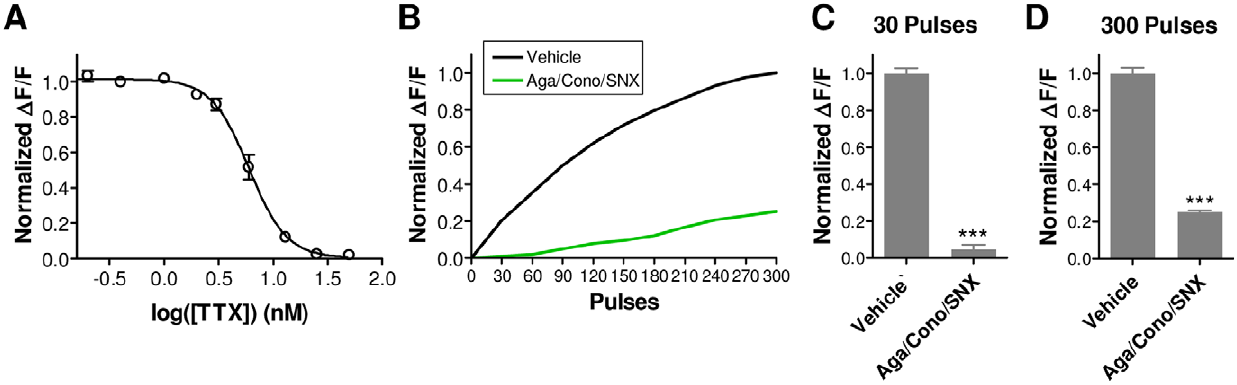
Figure 4. MANTRA system responses depend on action potential-mediated opening of presynaptic Ca ++ channels. ( A ) TTX concentration-response curve for response amplitudes to a 30 Hz, 10 sec pulse train from a single plate. Each point shows the mean 6 SEM of 8 wells normalized to within-plate vehicle controls. Data were fit with a standard sigmoid concentration-response function (R 2 =0.99). ( B ) SypHy fluorescence responses during a 30 Hz, 10 second stimulus train in the presence of the Cav2.1 inhibitor v -agatoxin IVA (500 nM), the Cav2.2 inhibitor v -conotoxin GVIA (1 m M), and the Cav2.3 inhibitor SNX-482 (1.2 m M). The waveforms depicted are an average of 24 wells for the vehicle and 8 wells for the treatment group. ( C,D ) Amplitudes (mean 6 SEM) of the sypHy responses shown in (B) following (C) 30 pulses (1 sec) and (D) 300 pulses (10 sec) of the stimulus train (***: p , 0.0001). doi:10.1371/journal.pone.0025999.g004 PLoS ONE |